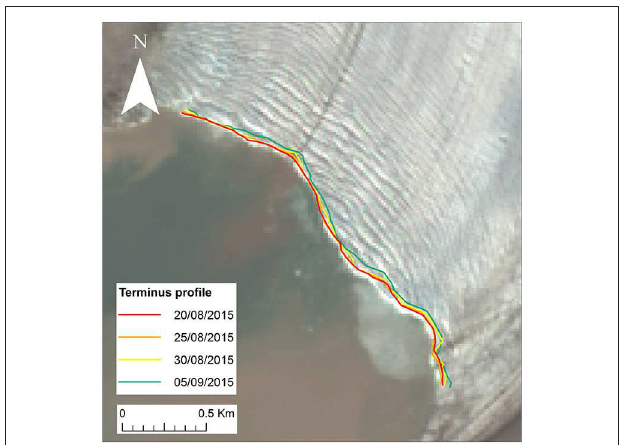
FIGURE 9 | An example of PyTrx’s ability to the extract sequential terminus profiles from Tunabreen camera TU1. The terminus profiles have subsequently been plotted onto a Landsat 8 satellite image, captured on 17 August 2015. A similar example of this is provided with PyTrx at